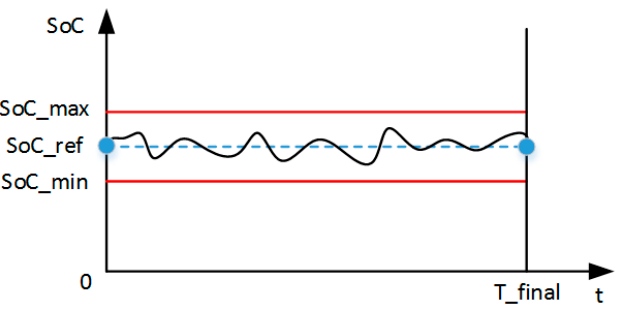
Figure 8. State of Charge ( SoC ) trajectory for charge-sustaining hybrid electric vehicles (HEVs). Figure 8. State of charge ( SoC ) trajectory for charge-sustaining hybrid electric vehicles